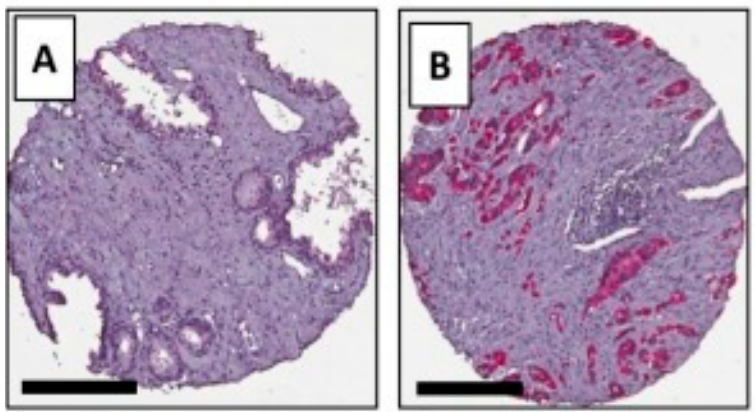
Figure 6. Immunohistological staining of AMACR from Shapovalova M. et al. 2018 (modified); Comparison between ( A ) a healthy prostate and ( B ) prostate cancer. Scale bars = 200 µm.